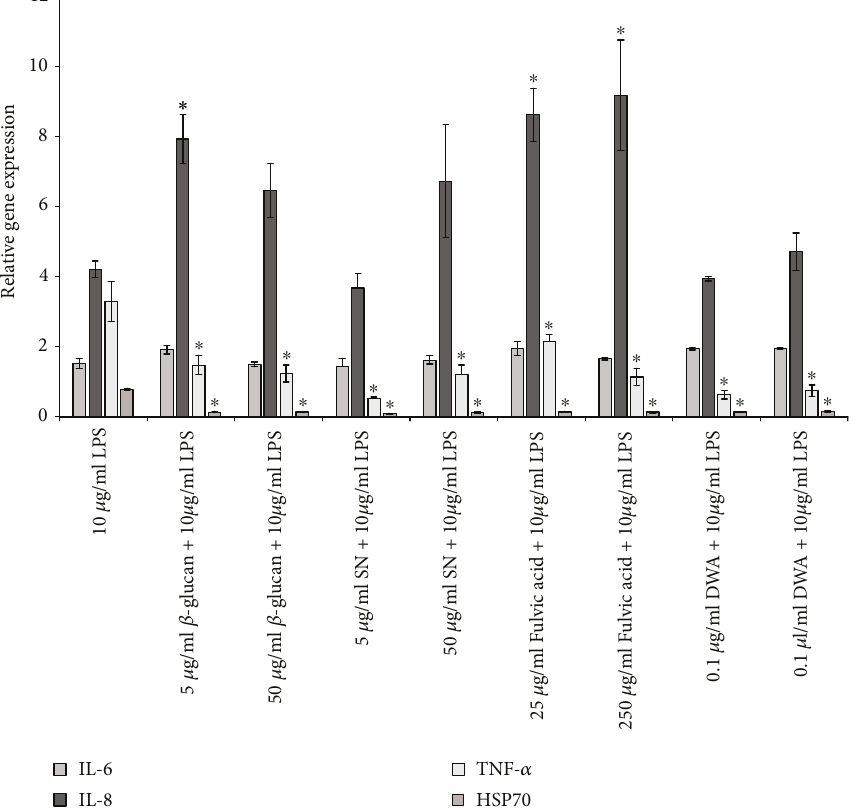
Figure 1: Relative gene expression (mRNA) of IL-6, IL-8, TNF- α , and HSP70 of IPEC-J2 cells exposed to LPS treatment (at 10 μ g/ml, 1h) compared to untreated controls ( n = 6 /group). Signi fi cant di ff erences are shown in comparison to LPS treatment ( ∗ p < 0 05 ) Data are shown as means ± SEM. LPS: lipopolysaccharide; SN: sanguinarine-containing product; DWA: drinking water acidi fi er; IL: interleukin; TNF- α : tumour necrosis factor alpha; HSP70: heat shock protein